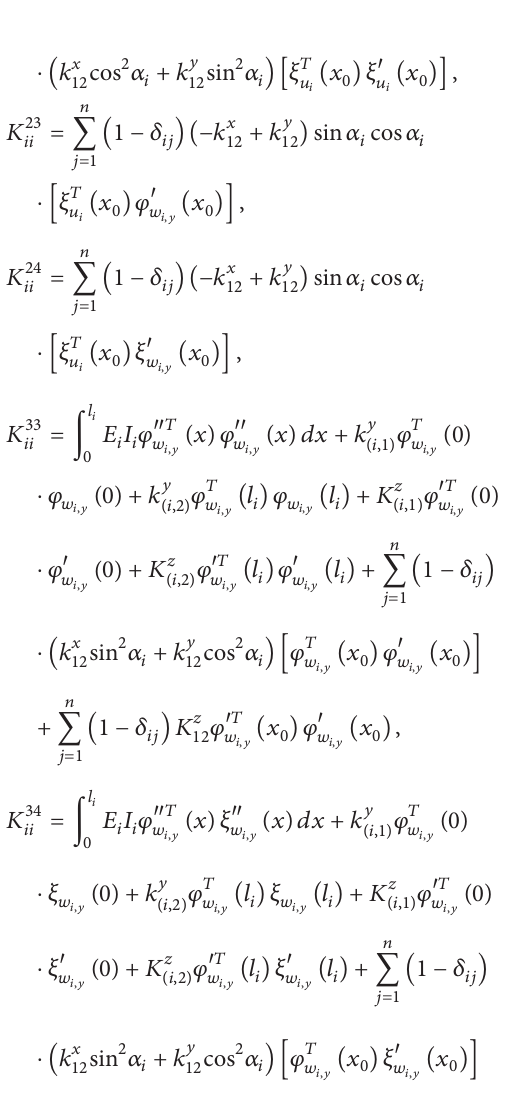
Figure 6: The first eight modes of coupled beams with 45 ∘ coupling angle: (a) the first mode, (b) the second mode, (c) the third mode, (d) the fourth mode, (e) the fifth mode, (f) the sixth mode, (g) the seventh mode, and (h) the eighth